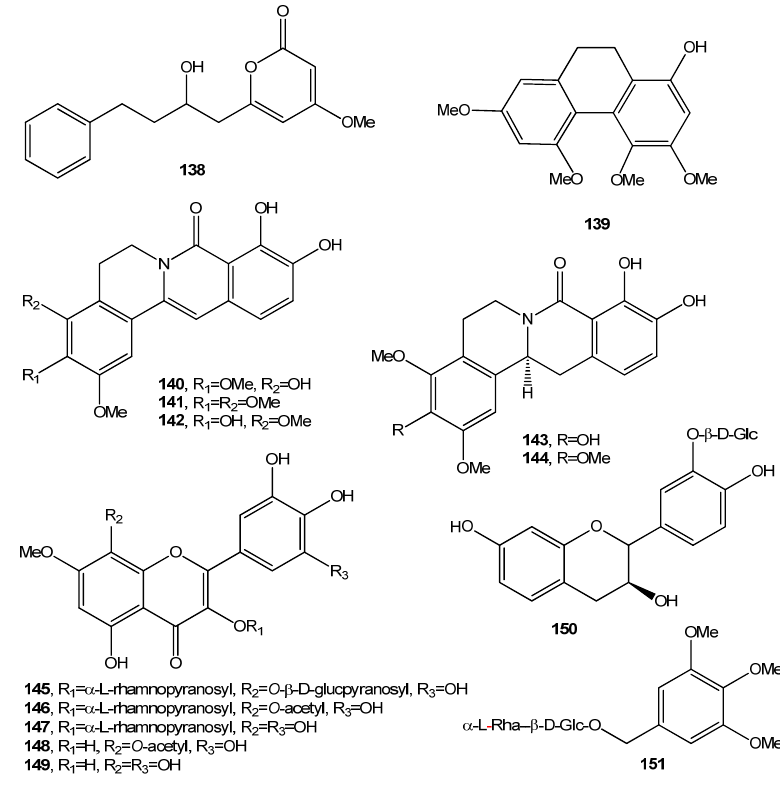
Figure 10. The structures of compounds 138 – 151 .